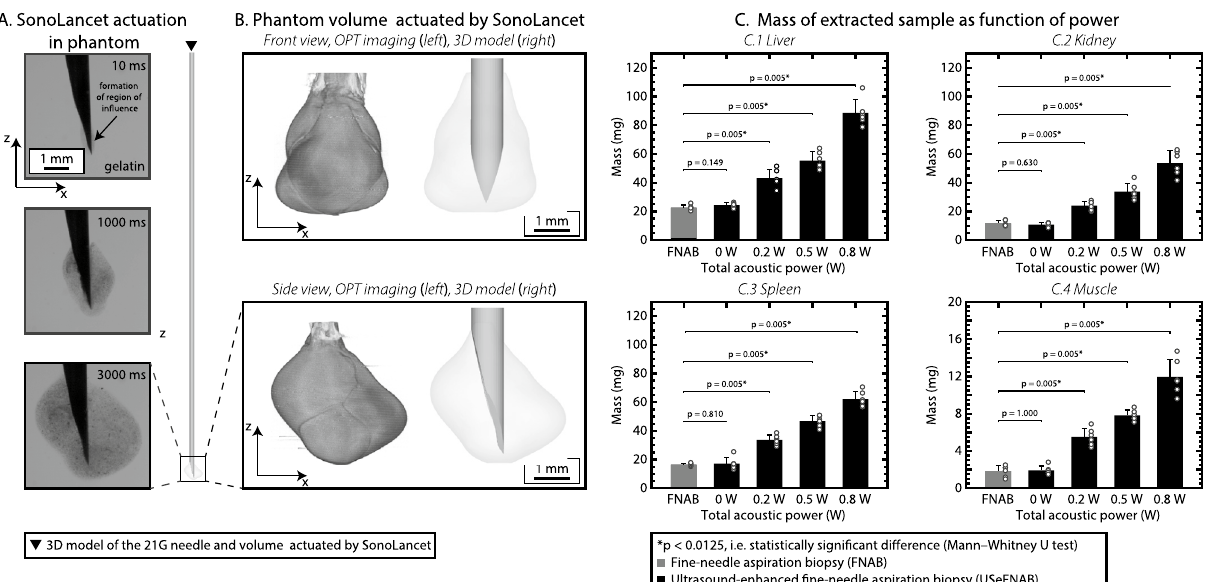
Figure 3. ( A ) HS imaging of experiments in tissue phantom (10% w/v ballistic gelatin/deionized water) reveals projections of the volume of interaction between the gelatin and the Sonance at different time points during continuous sonication. ( B ) A 3D reconstruction of the actuated region was produced by examining the sample under optical projection tomography. ( C ) The mass of extracted sample in ultrasound enhanced biopsies performed in bovine ( C (1)) liver, ( C (2)) kidney, ( C (3)) spleen and ( C (4)) muscle at different power levels compared to the standard FNAB. The needle employed in FNAB and ultrasound-enhanced FNAB (USeFNAB) was the same 21G needle. In the bar charts, the bar height represents the mean of the data set and the error bar indicates the standard deviation. Individual data points are shown as white-filled containing nanoparticles is localized near the needle tip (Fig. 3B). Dissection of the phantom was used to verify that the gel was liquefied. At the highest TAP levels, ∼ 0.8 W, we recorded a temperature rise of < 2 ◦ C or < 4 ◦ C during a 5 or 20 s sonication, respectively, suggesting that cavitation was the main mechanism of liquefaction 38 , rather than ultrasound-induced temperature rise. Even though the observed acoustic phenomena in gelatin may occur in a different fashion in an ex vivo tissue, this experiment gave us an insight on how the acoustic energy is manifesting and influencing the surroundings of the needle tip, when the needle has been confined by material with similar acoustic impedance to that of soft tissue. To demonstrate the influence of SonoLancet on tissue, we performed FNABs with and without ultrasound at the needle tip (ultrasound-enhanced fine-needle aspiration biopsy, USeFNAB) in different bovine tissues: liver, kidney, spleen and striated muscle. USeFNAB contributed to increased sample yield, whose weight increased with increasing TAP (p < 0.0125), being on average up to 4× the yield obtained with FNAB in liver, 5× in kidney, 3× in spleen and 6× in muscle (Fig. 3C). When ultrasound- enhanced biopsies were performed at the highest TAP (0.8 W), the average sample weight obtained in liver was 88.6 ± 9.3mg (average ± standard deviation; n = 6) (Fig. 3C(1)), 53.7 ± 8.6mg ( n = 6) in kidney (Fig. 3C(2)), 62.2 ± 5.4 mg ( n = 6) in spleen (Fig. 3C(3)) and 11.9 ± 1.9mg ( n = 6) in muscle (Fig. 3C(4)); the sample masses obtained with FNAB were respectively 22.7 ± 1.8mg ( n = 6), 11.7 ± 2.0mg ( n = 6), 16.6 ± 1.0mg ( n = 6) and 1.8 ± 0.6mg ( n = 6). Based on a histopathological evaluation, performed by a pathologist (K.P.H.P.) with > 40 years of histopathology and cytopathology experience, all tissue types included intact cells and tissue (Fig. 4) containing histologically relevant structures that could be observed in all samples. A computer-assisted method was adopted to quantify the fragmentation in the liver samples (Fig. 5A). The area of tissue fragments (large regions of adjacent hepatocytes), cell clusters (small aggregation of hepatocytes), single cells and debris pieces (organic waste) detected in the control group slides (FNAB) were measured and compared to the experimental groups (USeFNAB, TAP levels: 0 W, 0.2 W, 0.5 W and 0.8 W). On average the total areas of tissue fragments, cell clusters, single cells and debris pieces were slightly influenced by ultrasound; however, they were not statistically significantly different from the respective areas of FNAB (p > 0.0125). At the highest TAP the relative total area of tissue fragments was lower ( 57.9 ± 9.5% , average ± standard deviation, n = 6, p = 0.0306) as compared to FNAB ( 69.9 ± 5.8% , n = 5) (Fig. 5B(1)). The relative total area of cell clusters and individual cells were not different from those of FNAB when the highest TAP was employed (p = 0.0656 and p = 0.8102, respectively) (Fig. 5B(2,3)). The relative total debris area ( 17.2 ± 4.6% , n = 6, p = 0.0131) was higher as compared to FNAB ( 11.0 ± 2.3% , n = 5) (Fig. 5B(4)). the actuation of tissue induced by SonoLancet.